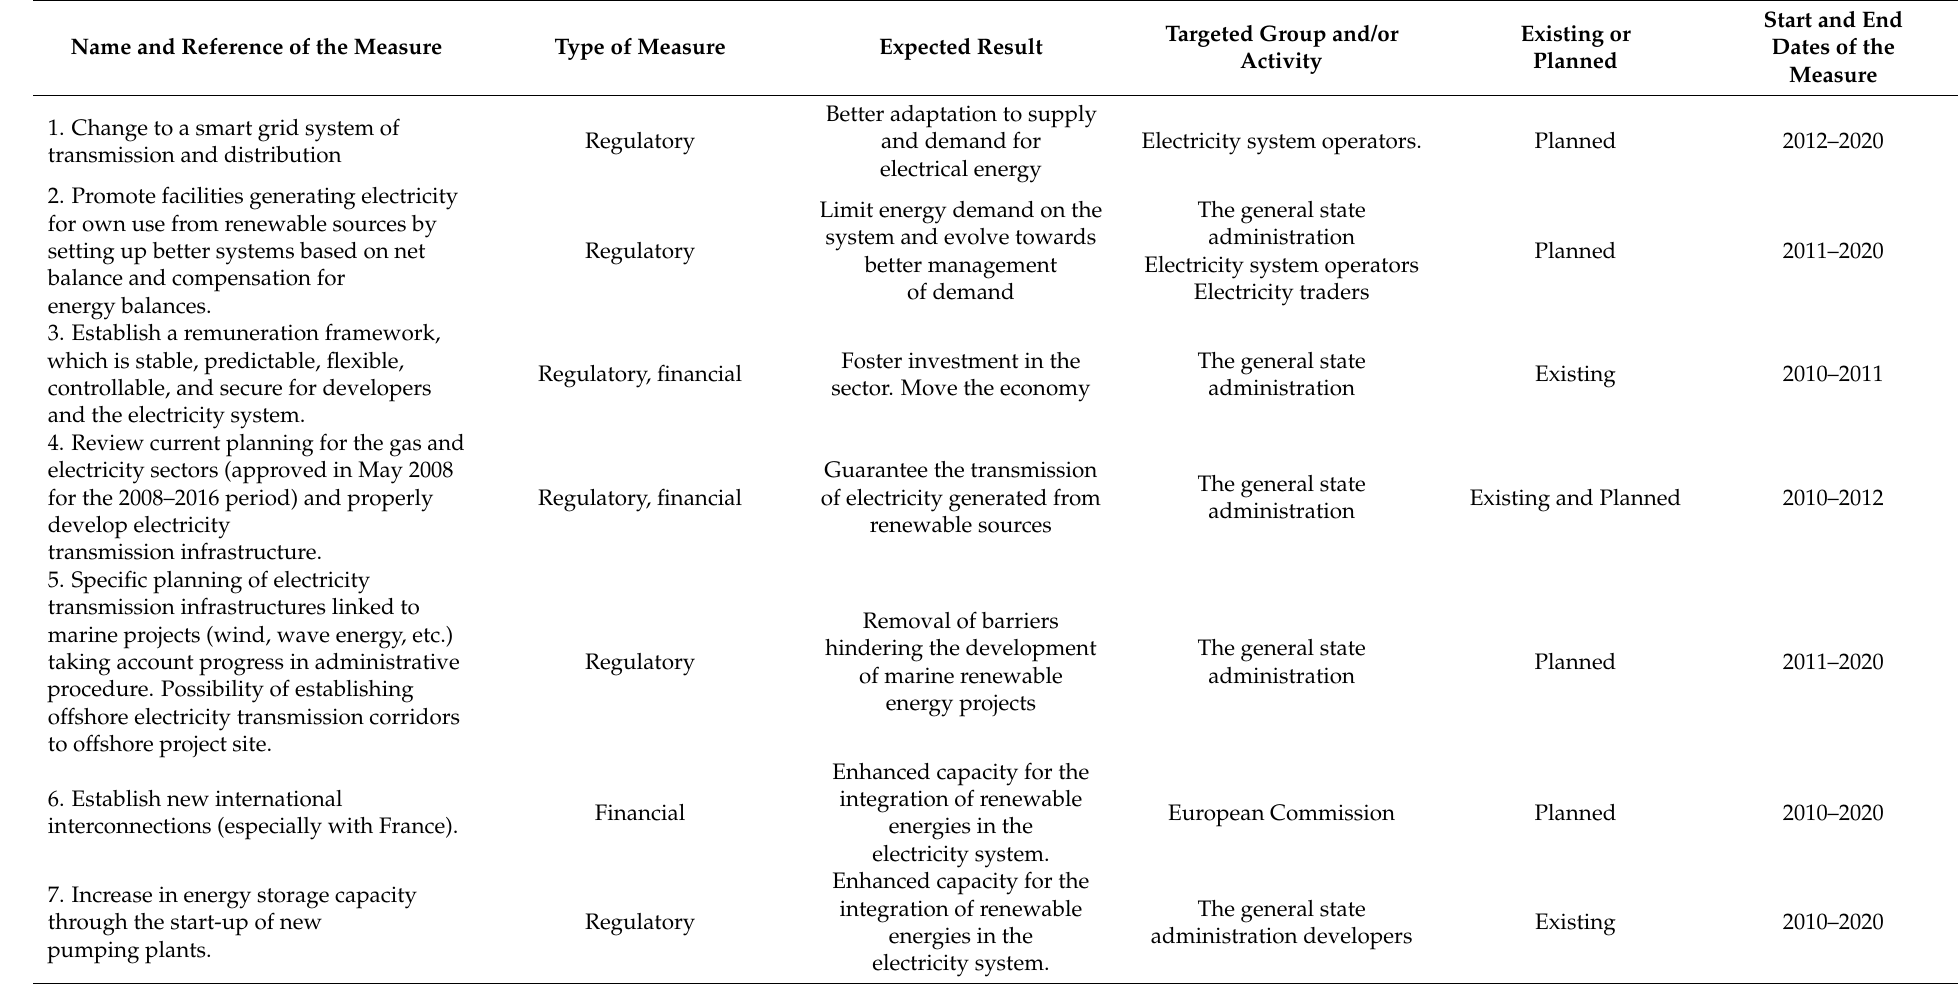
Table 5. Measures in the field of electricity generation using renewables